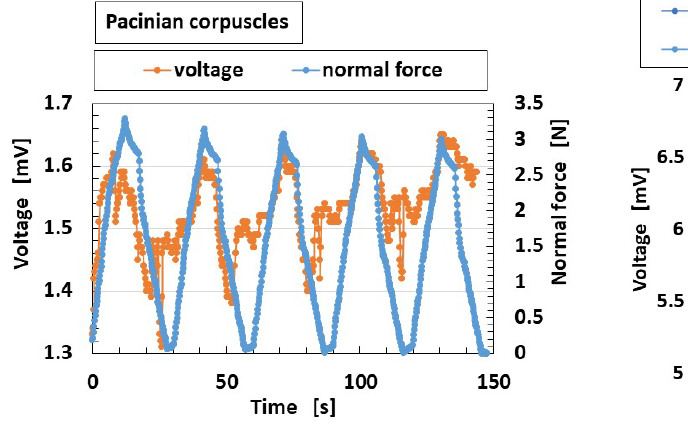
μm). A smooth object ( R a = 0.03 μm, R q = 0.03 μm, R y = 0.2 μm) was placed between the other